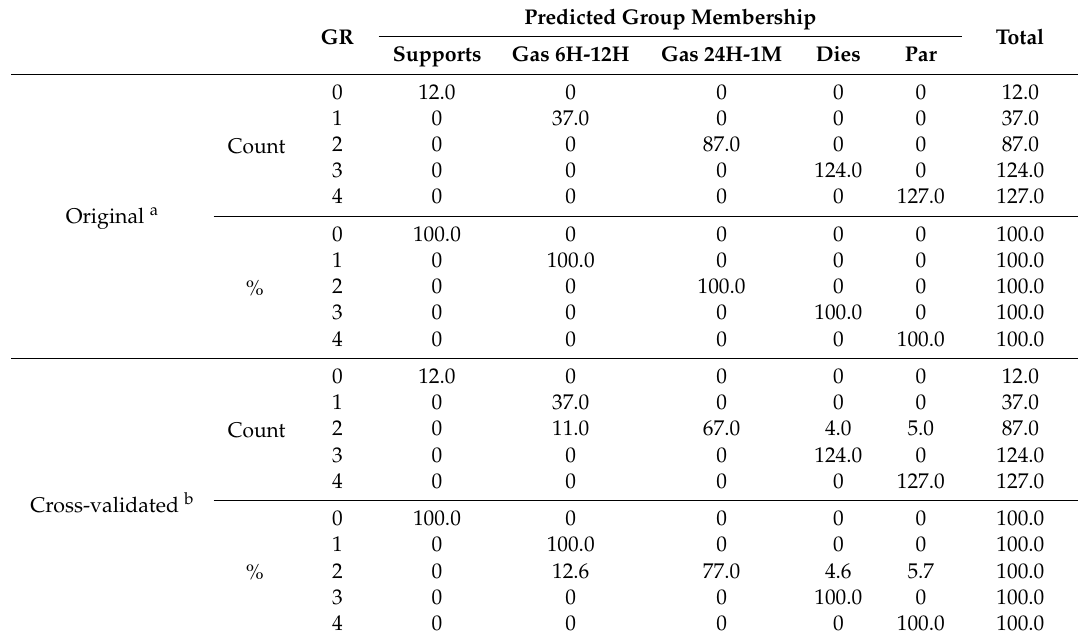
Table 2. Classification results from the linear discriminant analysis ( n =